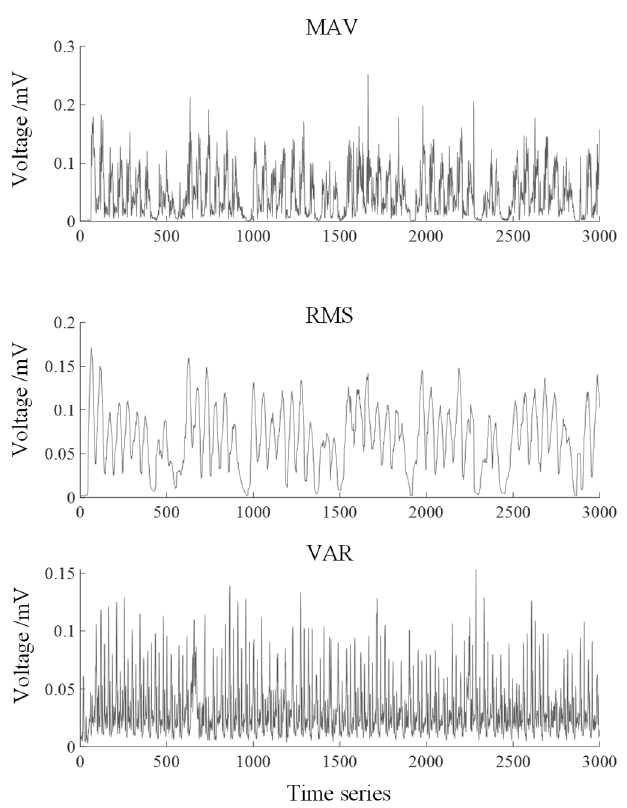
Figure 3. Three time − domain feature diagrams.